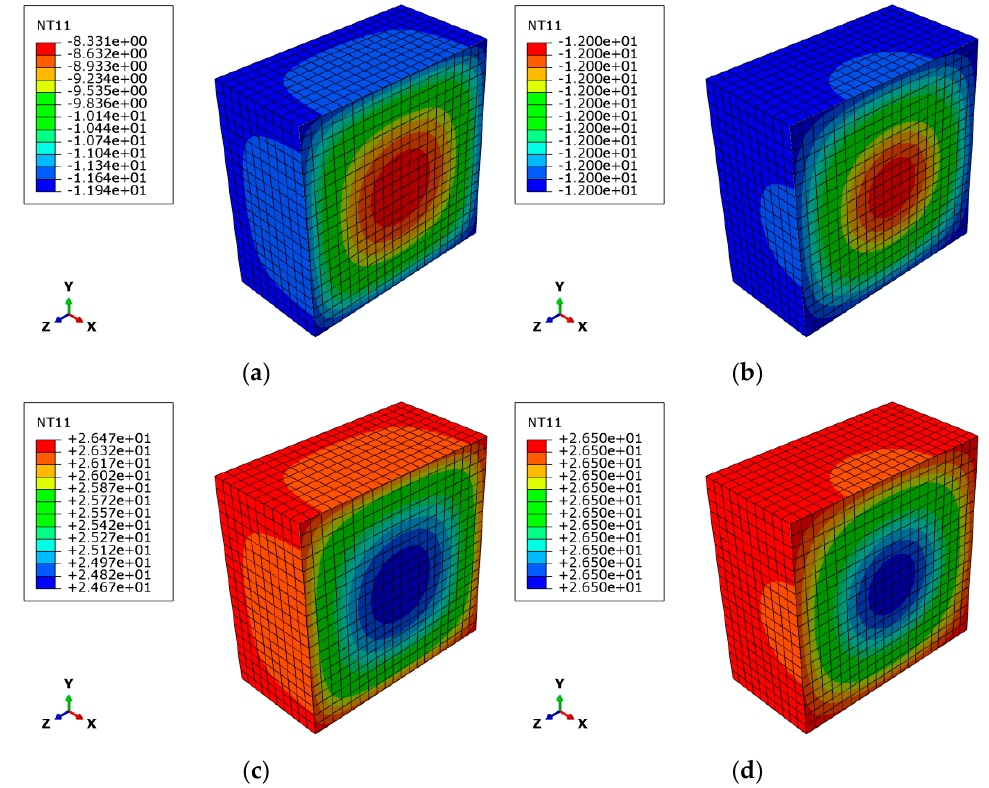
Figure 8. Distribution state and overall change process of the temperature of gray brick from inside to outside during one freeze–thaw cycle: ( a ) the 1st hour; ( b ) the 1.7th hour; ( c ) the 6th hour; ( d ) the 6.7th hour.